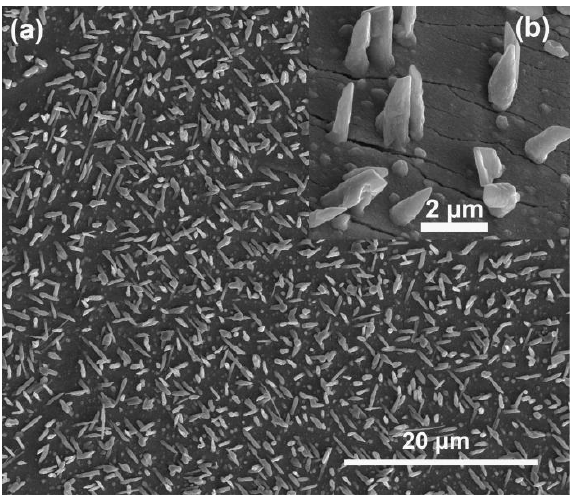
Figure 4. ( a ) SEM image of the InN grown on pure Cu substrates. ( b ) Enlarged SEM image of the InN/Cu products.